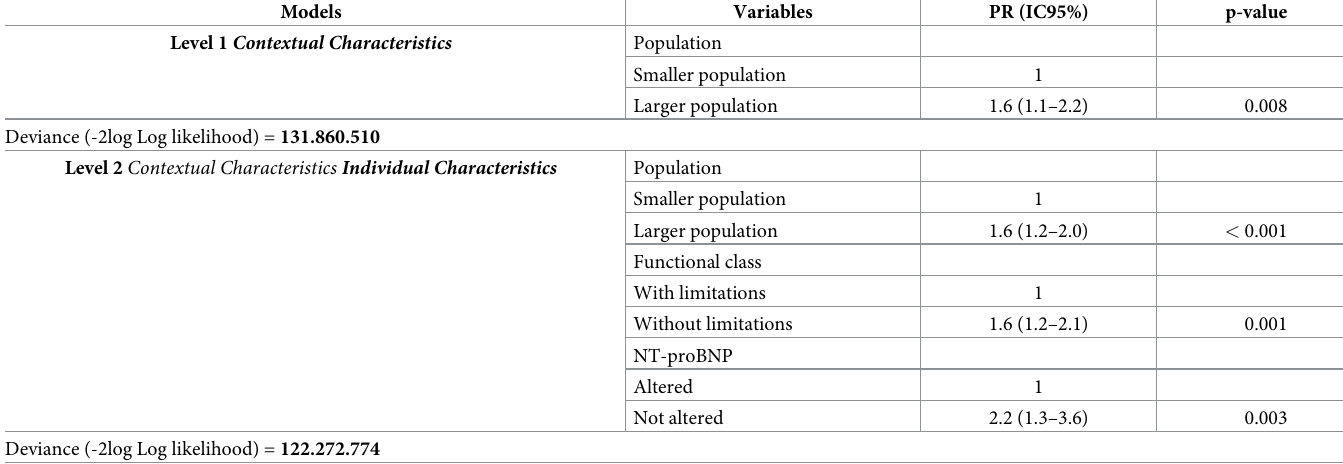
Table 3. Final model of the Multilevel Poisson Regression of the factors associated with the non-use of health services in the last year by people with Chagas disease. Minas Gerais, Brazil (n =